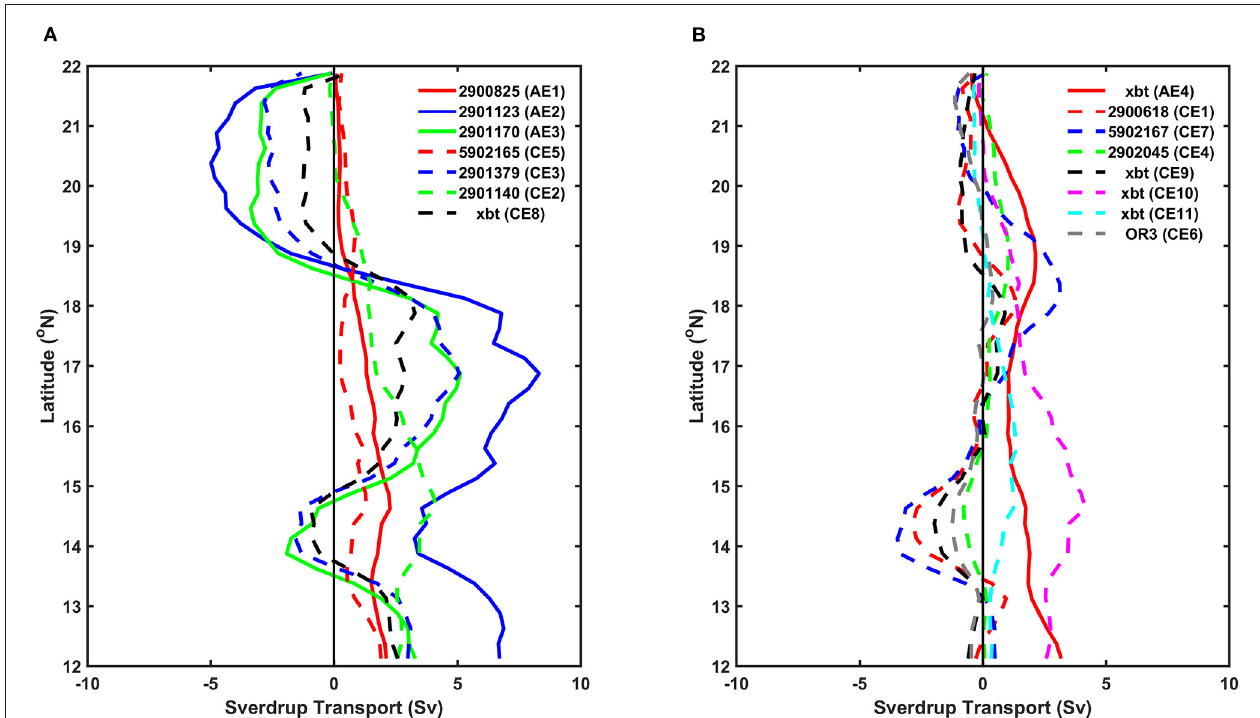
FIGURE 13 | Meridional distribution of Sverdrup transport averaged within 109 ◦ E and 120 ◦ E during the month and a month before observing the ocean eddies via Argo floats and expendable bathythermographs (XBTs). (A) Cases with significant eddy pumping. (B) Cases without significant eddy pumping. Solid and dashed curves are for the anticyclonic and cyclonic eddies, respectively. Only considering depth larger than